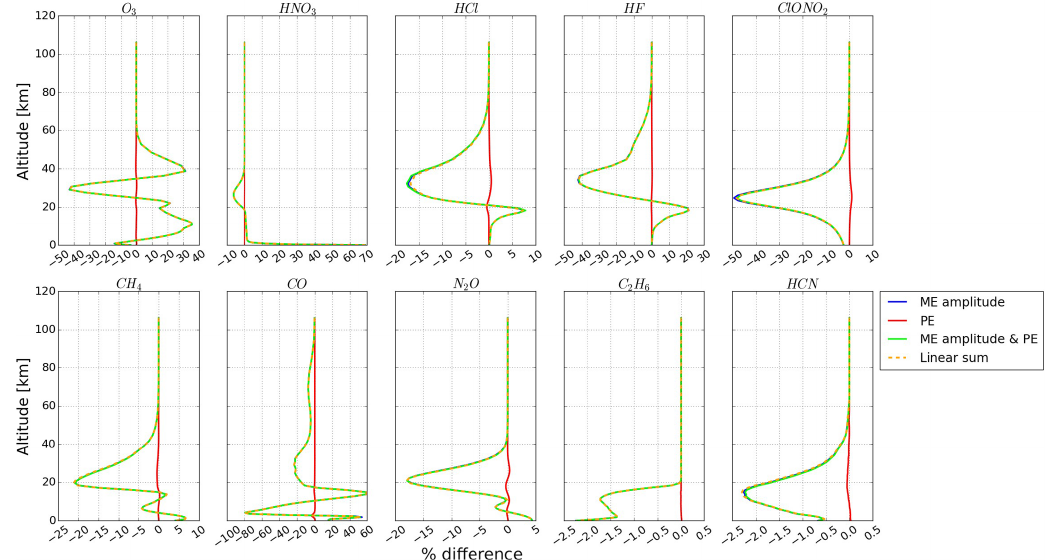
Figure 7. Fractional difference in the profile for misalignment j. The nomenclature in the plot legend is the same as Fig. 6. The results are deduced from the spectra recorded at Hefei on 16 February